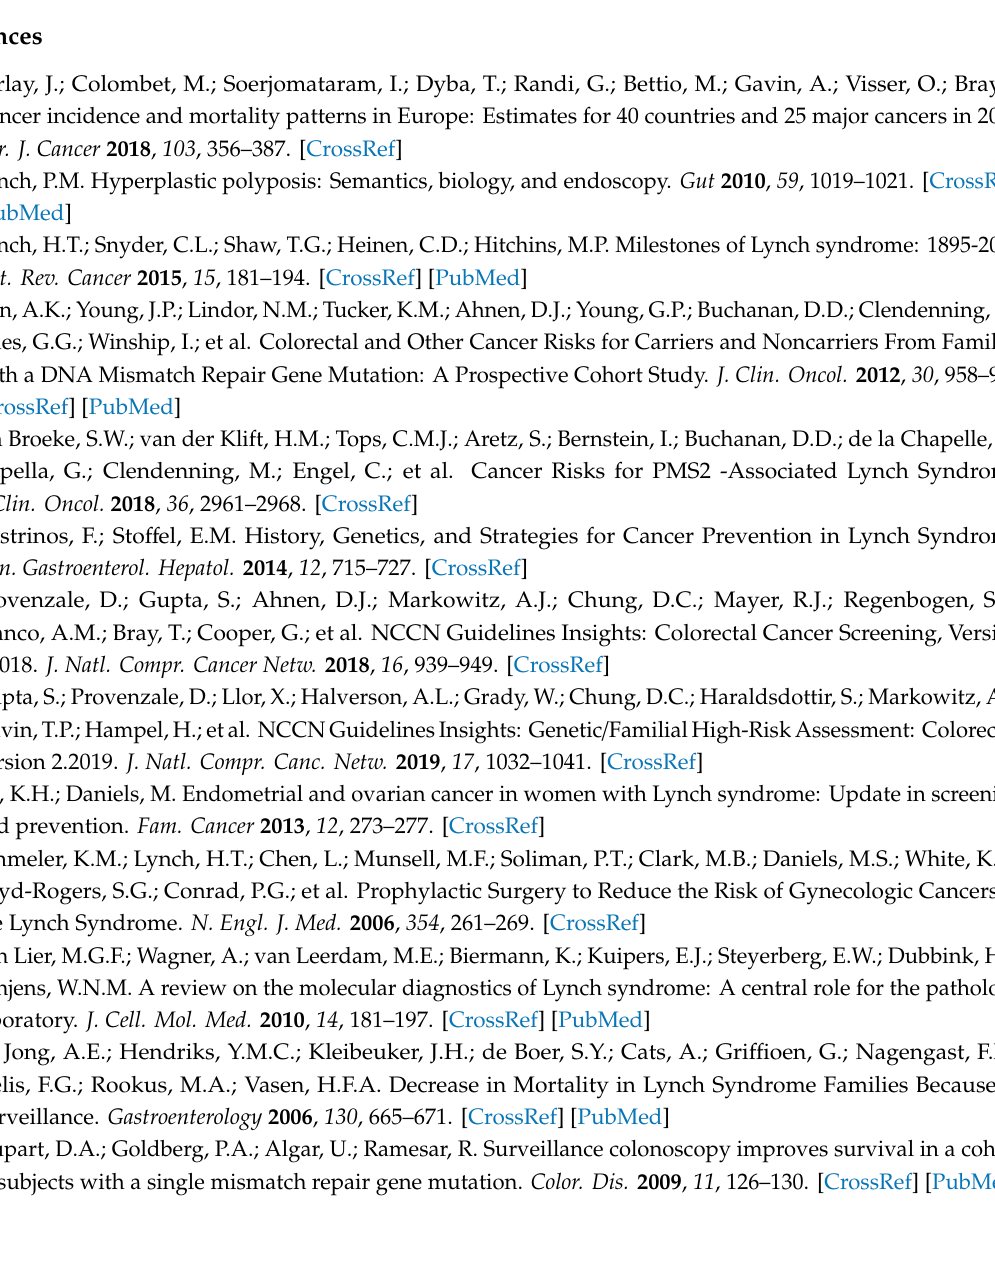
Table S1: Variants detected in PMS2 in sample collected from proband’s peripheral